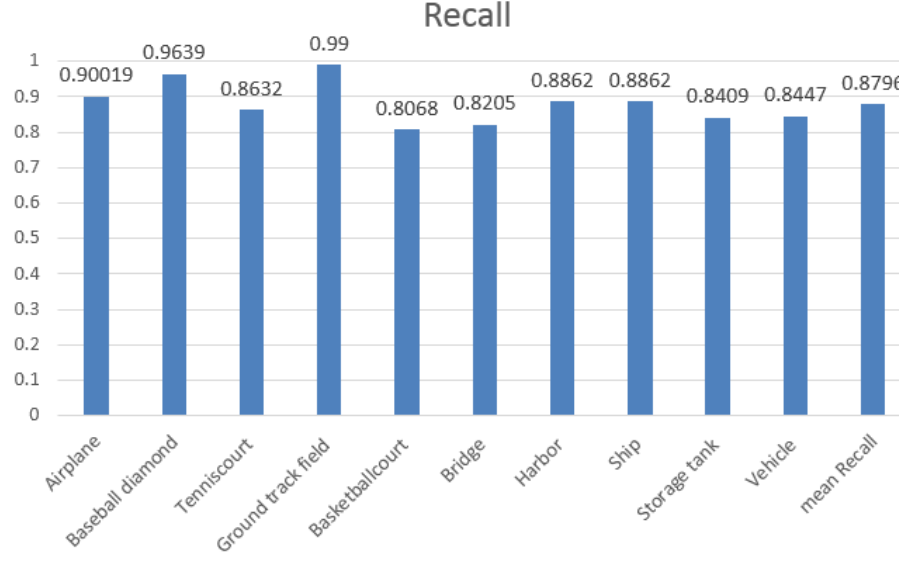
Figure 7. Aspect ratio of training annotations.